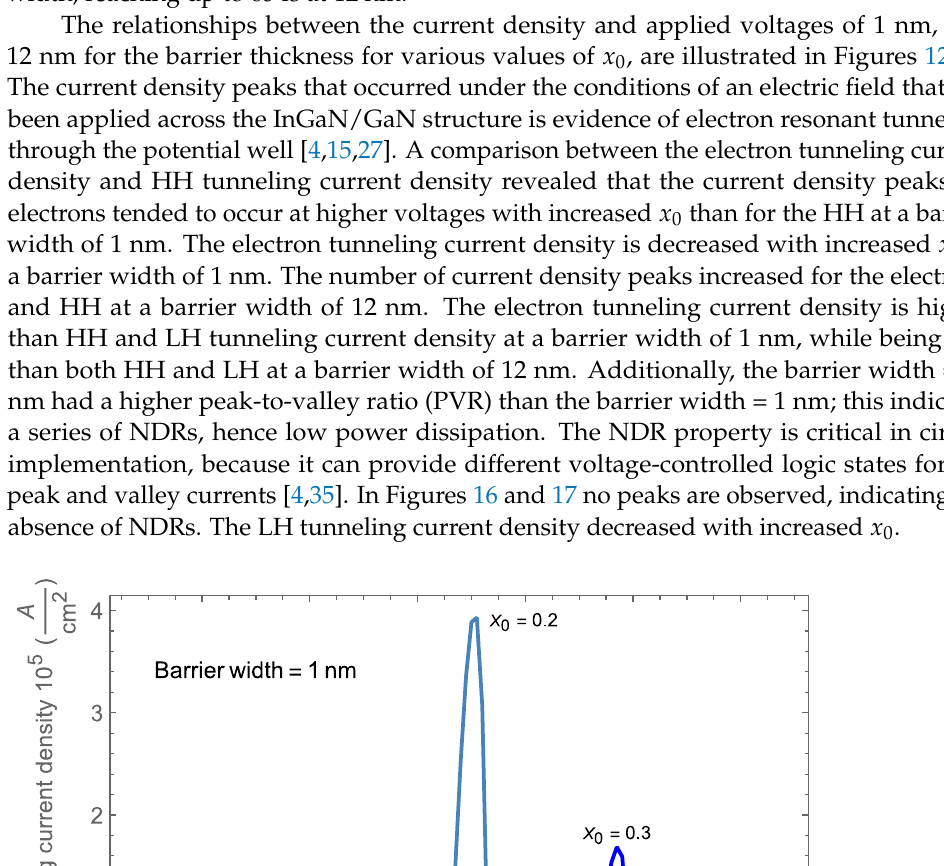
Figure 13. Current density-voltage characteristics of the HH tunneling at width barrier 1 nm.